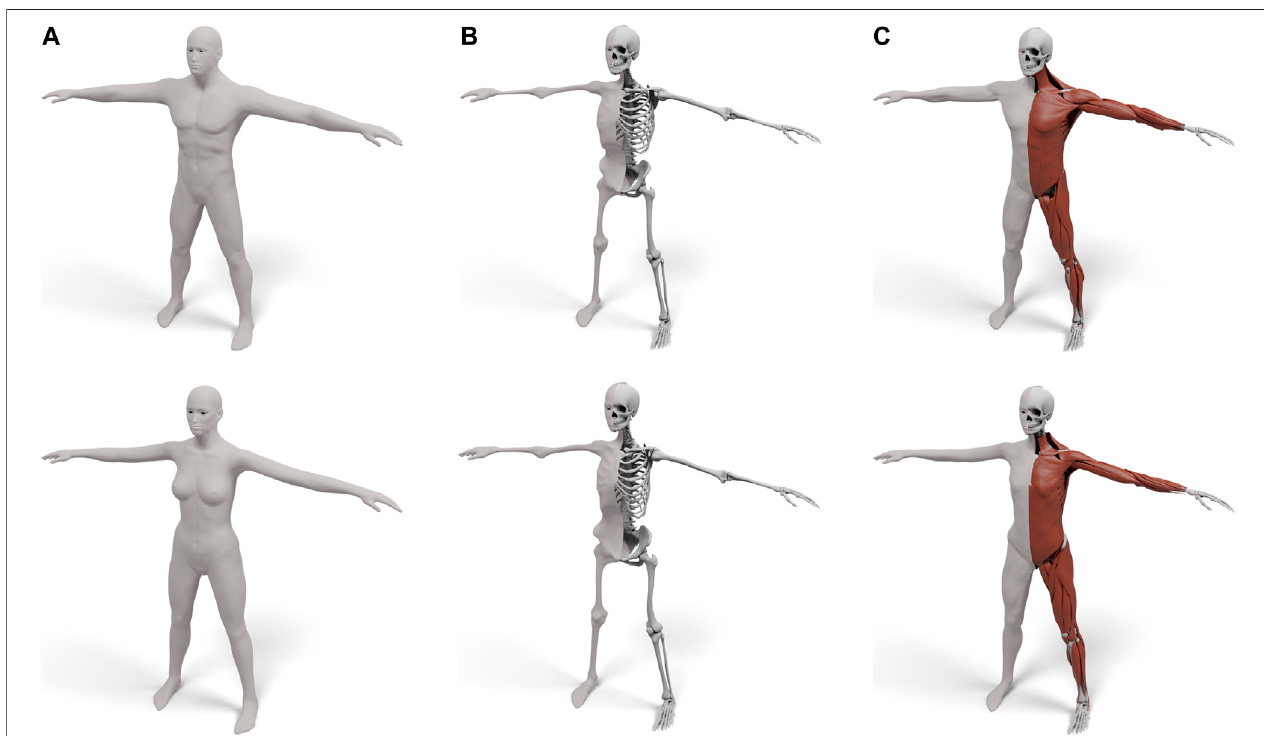
FIGURE 3 | Our layered template for both male (top) and female (bottom) : the skin surface (A) , the skeleton surface enveloping the skeleton (B) , and the muscle surface enveloping both muscles and skeleton (C) . For (B) and (C) the left half shows the enveloping surface, the right half the enveloped anatomical details.